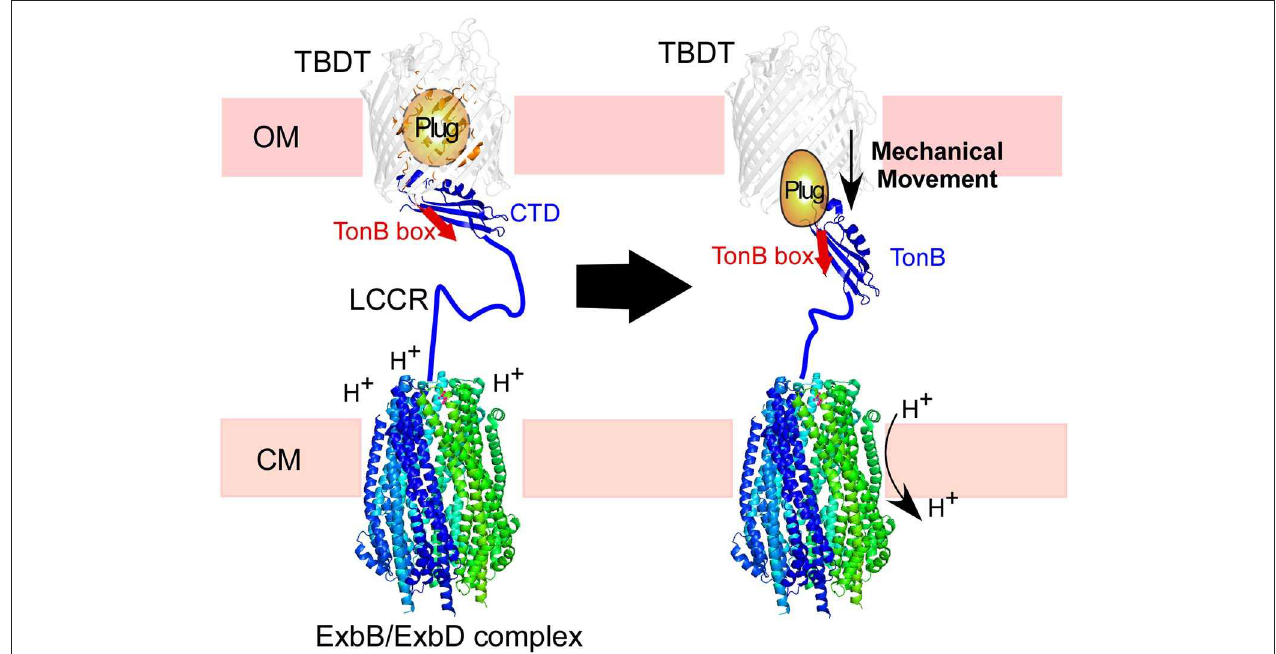
FIGURE 1 | Illustration of TonB-dependent transporters (TBDT) in the cell envelope of Gram-negative bacteria. The C-terminal domain (CTD) of TonB is proposed to interact with the TonB box in the plug domain of TBDT (left). The proton-motive force across the cytoplasmic membrane (CM) is transduced by the ExbB/ExbD complex to induce mechanical force via TonB. The low complexity central region (LCCR) spans in the periplasmic space to interact with TBDTs in the